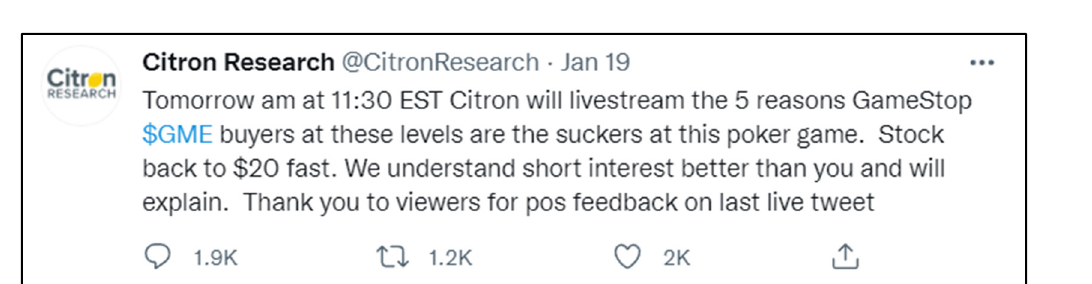
Figure A1. The Citron Research tweet that rallied WallStreetBets. Source: [26].